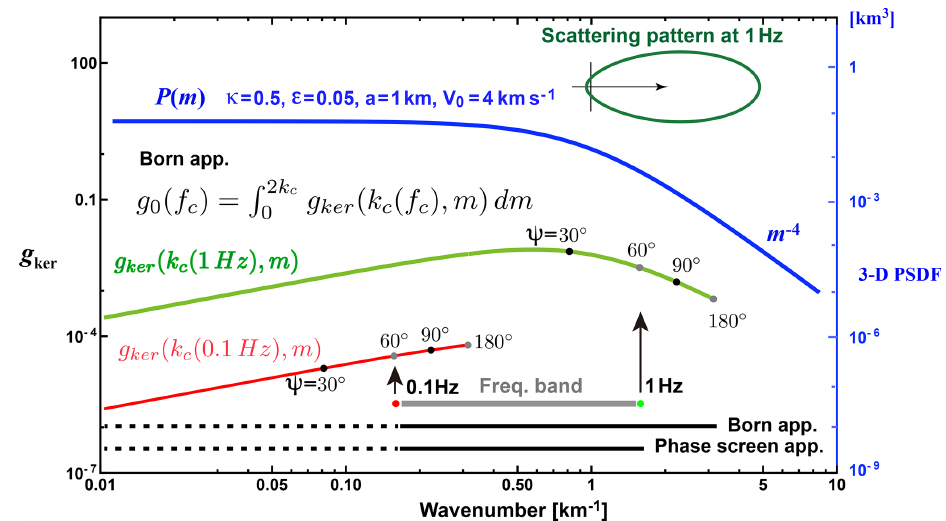
Figure 7. Plot of P(m) (blue, right scale) and the spectral kernel of the scattering coefficient g ker (k c (f c ),m) at f c = 0 . 1Hz (red, left scale) and 1Hz (green, left scale) according to the Born approximation. Scattering angles are marked by dots on each trace. For the case of the frequency band between 0.1 and 1Hz, the phase screen approximation based on the parabolic approximation covers the wavenumber range from 0 to the upper bound (line at the bottom); however, the Born approximation covers the range from 0 to twice the upper bound (line next to the bottom). We also use these line styles in Figs. 3–5 and